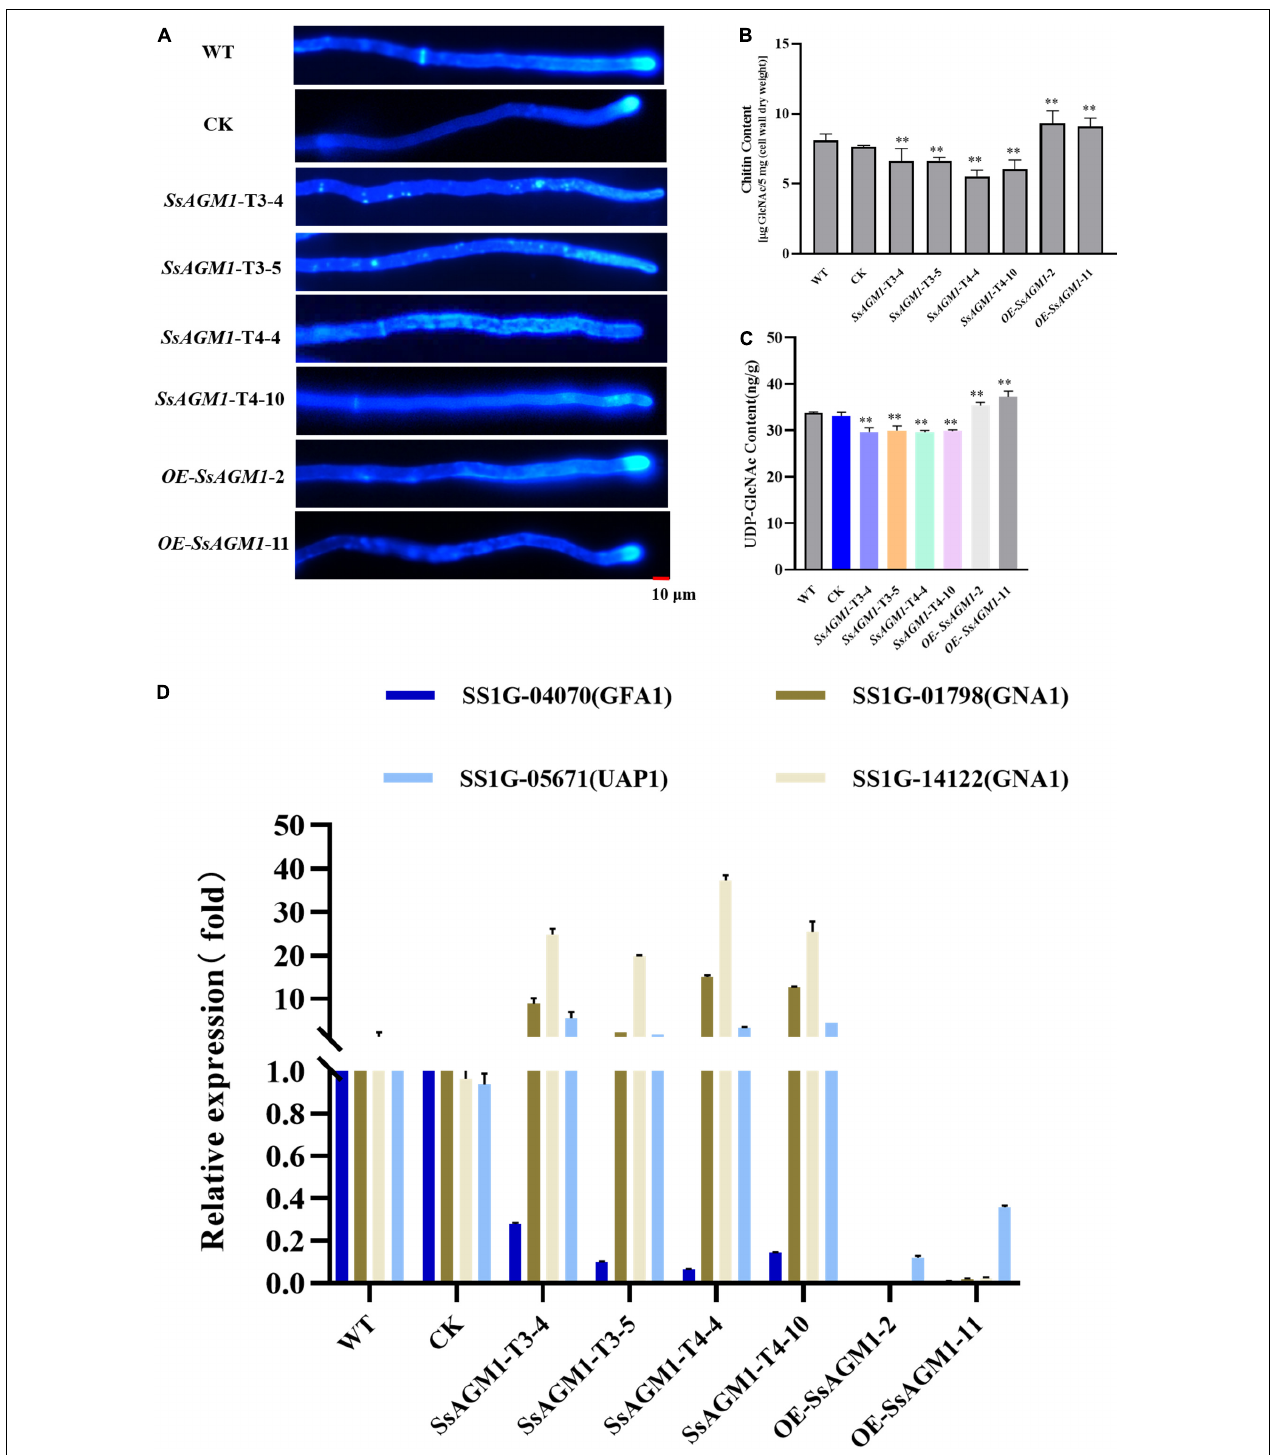
FIGURE 3 | SsAGM1 is involved in UDP-GlcNAc and chitin synthesis in Sclerotinia sclerotiorum . (A) Wild-type strain, control strain, gene-silenced transformants, and overexpression transformants were treated with Calcofluor white (CFW) and observed using a fluorescence microscope. Strains were inoculated on PD for 12 h, and hyphae were stained by CFW (10 µ g/mL) for 3 min in the dark. Scale bars, 10 µ m. WT, Wild-type strain; CK, the control strain. (B) The determination of chitin content used the fluorimetric Morgan-Elson method. (C) Quantitation of UDP- GlcNAc content. Data represent means ± SD, n = 3. One-way ANOVA; ∗∗ represents significant difference from WT at p < 0.05. (D) The analysis of the expression of key genes in the UDP-GlcNAc synthesis pathway by RT-qPCR. GFA1, glutamine: Fru-6P amidotransferase; GNA1, GlcN-6P acetyltransferase; UAP1, UDP-GlcNAc pyrophosphorylase. Error bars: the standard deviation of three replicates.